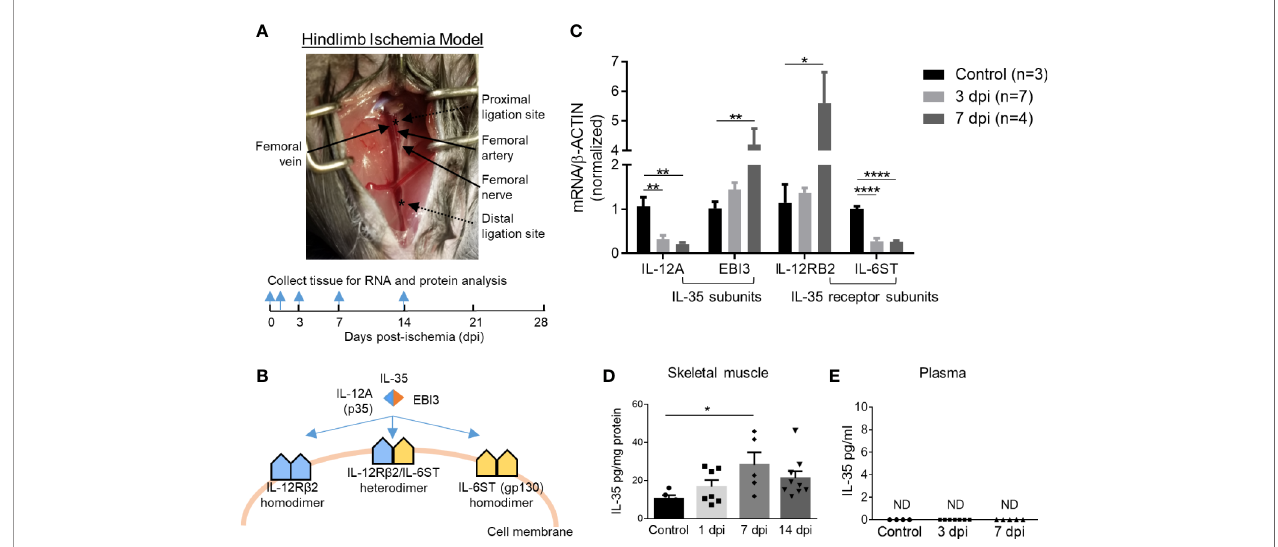
FIGURE 1 | IL-35 and its receptor subunit IL-12RB2, but not IL-6ST, are induced in the ischemic muscle after hindlimb ischemia (HLI). Calf muscle including gastrocnemius and soleus was used in (C, D) . (A) Schematics of HLI surgery and the time points of tissue collection. (B) Schematics of IL-35 signaling complex. (C) Normalized gene expression of IL-35 signaling complex in ischemic muscle at pre-ischemia (control), 3 and 7 days post-ischemia (dpi). (D, E) IL-35 protein level in skeletal muscle and mouse plasma at indicated dpi. All animal results were collected from male mice. Data are presented as mean ± SEM. ND, not determined; *p < 0.05; **p < 0.01; ****p <